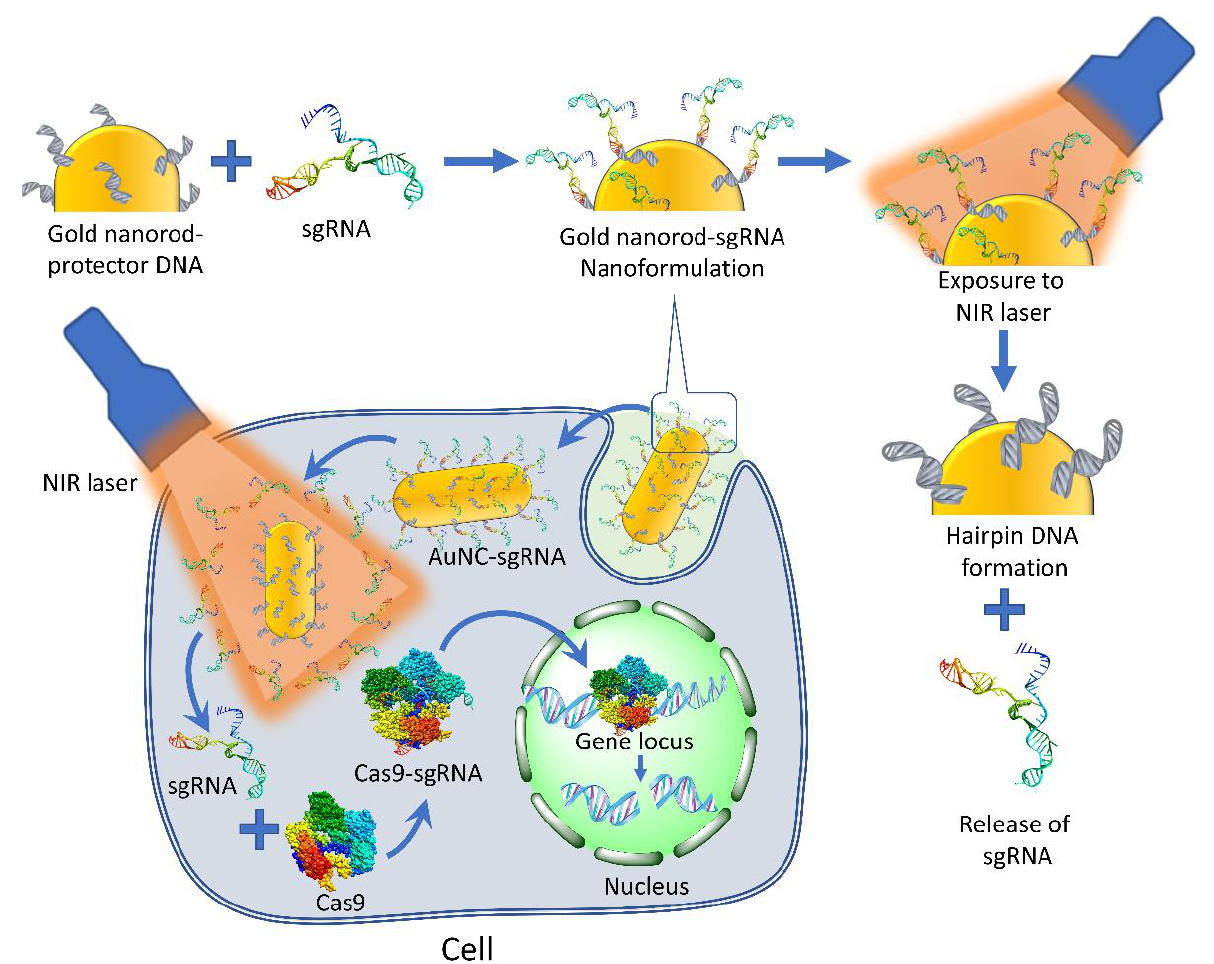
Figure 10. Photo-responsive intracellular CRISPR/Cas9 nanoformulation delivery. sgRNA hybridization with a protector DNA, sgRNA release after heat activation, hairpin structure formation of protector DNA, and sgRNA release within the cells.